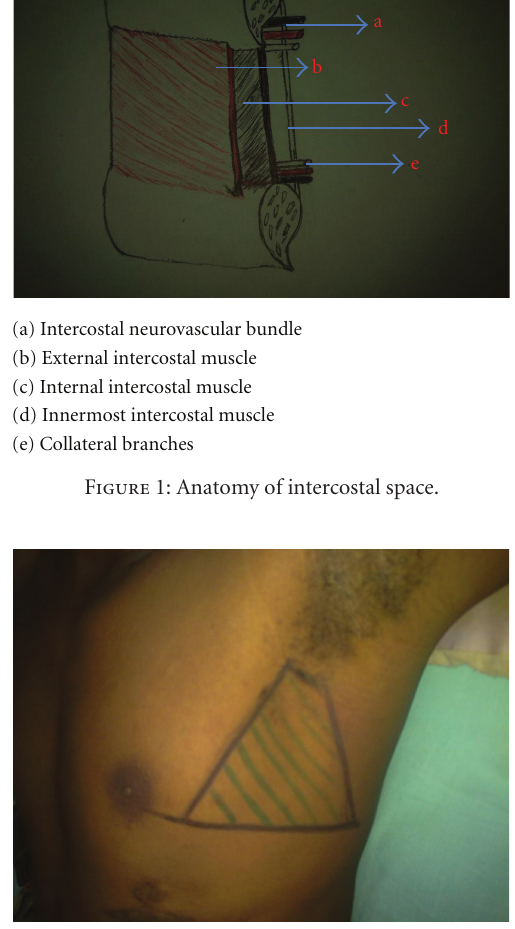
Figure 2: Triangle of